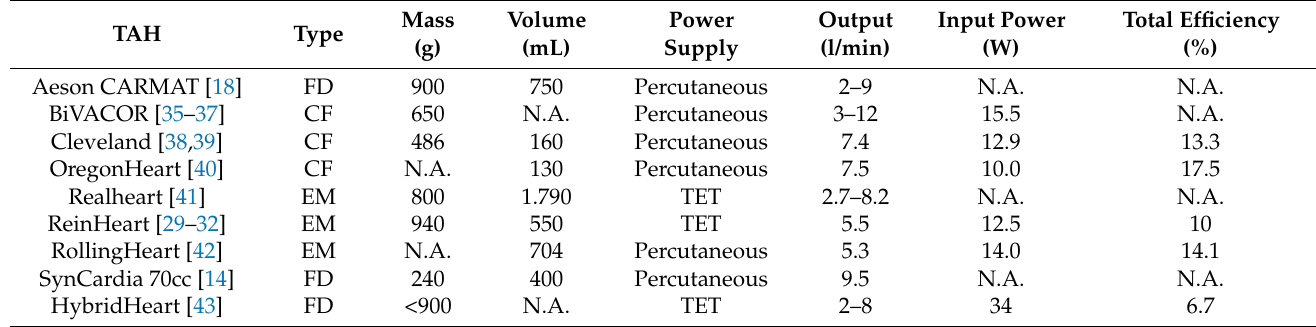
Table 1. Main data from approved or under development TAH